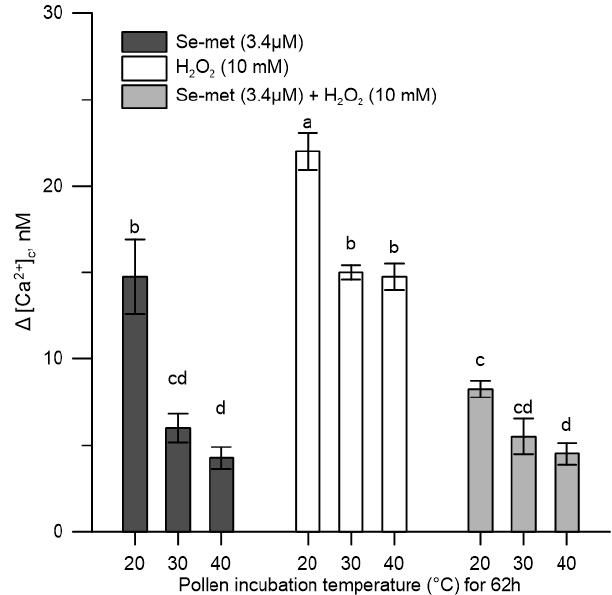
Figure 2. Changes in Ca 2+ -cytosolic ( Δ [Ca 2+ ] c ) in olive pollen incubated at 20, 30, and 40 °C, in the presence of Se-met (3.4 µM), H 2 O 2 (10 mM), and Se-met (3.4 µM) + H 2 O 2 (10 mM). Values are expressed as means ± SEM. Different letters indicate statistically significant differences ( p < 0.05).